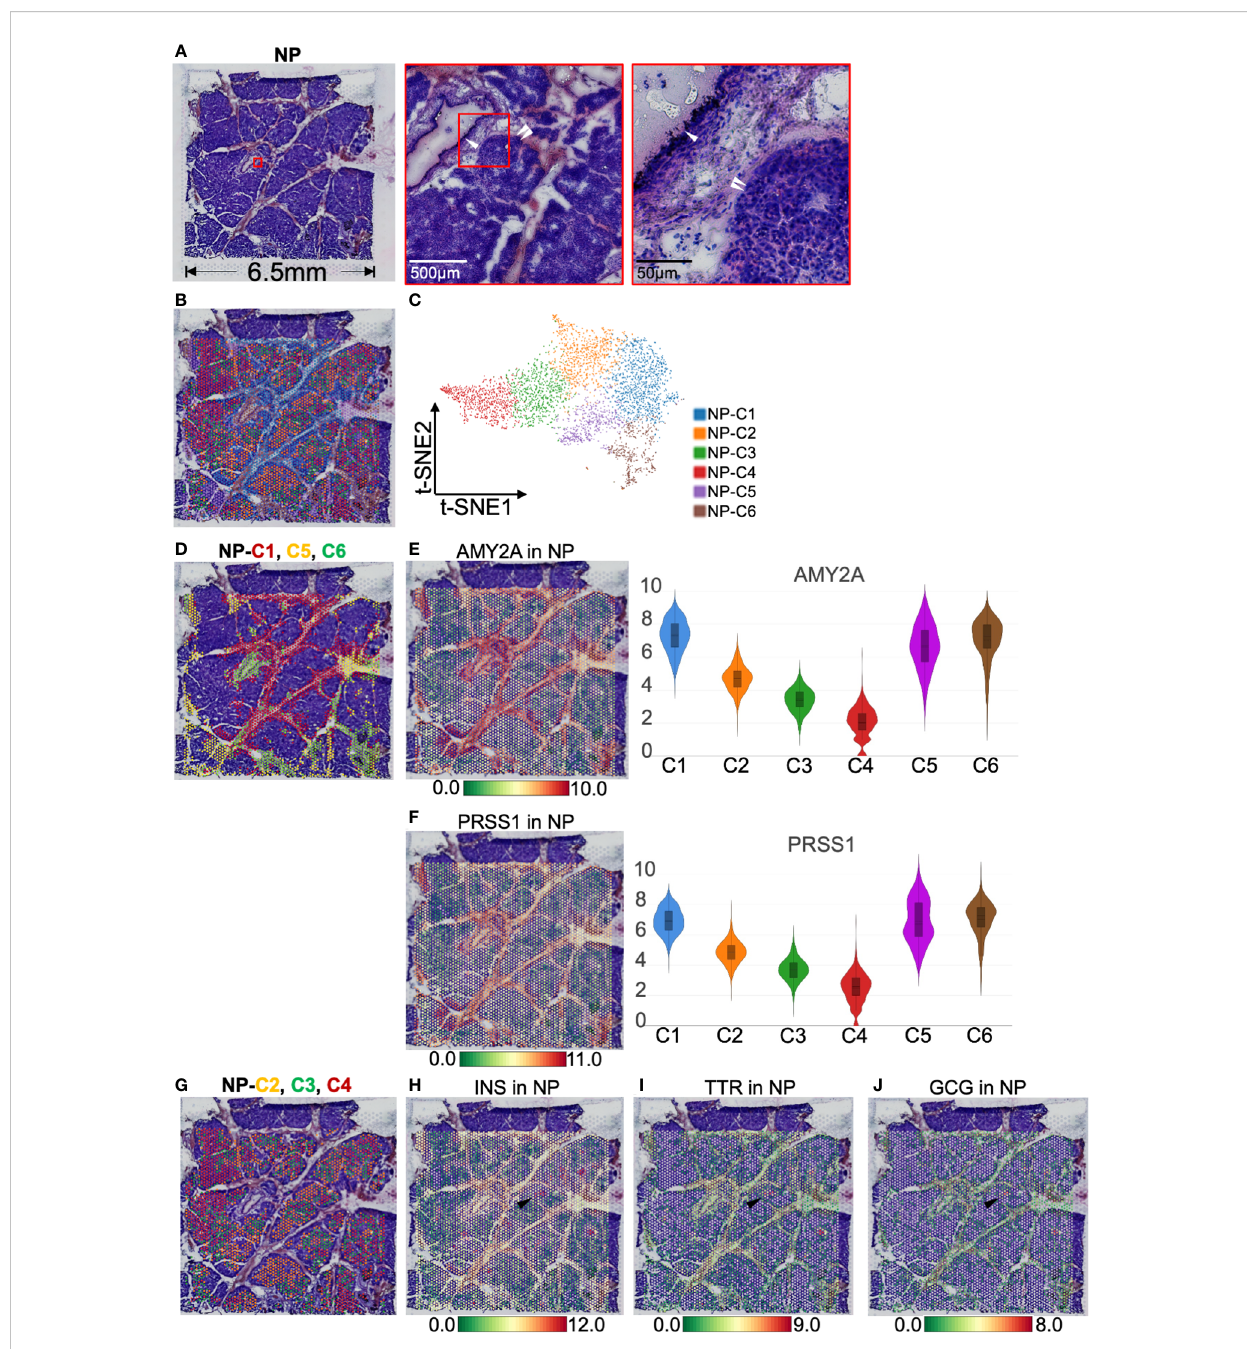
FIGURE 2 Clustering and spatial localization of endocrine and exocrine parts in normal pancreas (NP). (A) Hematoxylin and eosin (H&E) images of NP. The red box shows pancreatic duct (white single arrow) and islets (white double arrow). (B) A total of 4,724 spots were grouped into six clusters in different colors and were distributed in the NP compartment. (C) t-SNE plot of spatial transcriptomics indicating six clusters. (D) H&E image showing NP- Cluster (C)1 (red spots), -C5 (yellow spots), and -C6 (green spots) are located around pancreatic ducts. Spatial distribution and expression abundance of AMY2A (E) and PRSS1 (F) . (G) H&E image showing NP-C2 (red spots), -C3 (green spots), and -C4 (red spots) occupy most of the NP area, surrounded by pancreatic ducts. Spatial distribution and expression level of INS (H) , TTR (I) , and GCG (J) . Black arrows highlight the spots at the same position and simultaneously express INS, TTR, and GCG. The bar plots and the vertical coordinate of the violin plots indicates the log 2 FC of the gene expression value of each cluster versus the average gene